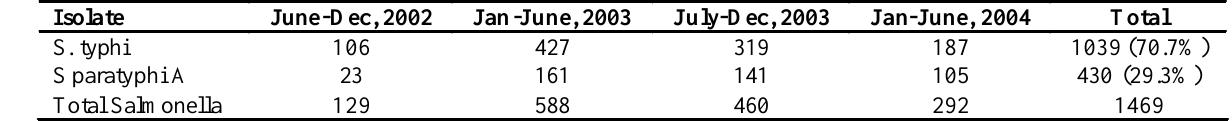
Table I : Distribution of total Salmonella isolates collected